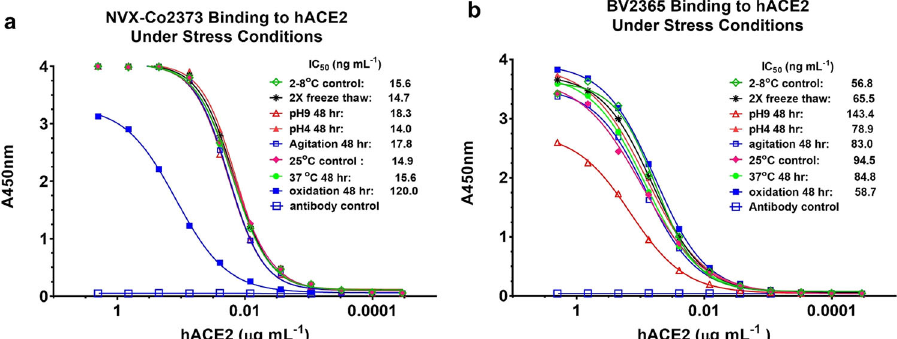
Fig. 3 Stability of SARS-CoV-2 variants under stress conditions. The hACE2 receptor binding ELISA method was used to assess the structural integrity of BV2365 and NVXCoV2373 under stressed conditions. a NVXCoV2373 and b BV2365 were exposed to repeat freeze – thaw cycles, pH extremes, agitation, elevated temperatures, and oxidation for extended periods as indicated. Treated samples were immobilized on 96-well plates, then incubated with serially diluted (2 – 0.0001 μ g mL − 1 ) histidine-tagged hACE2. Bound receptor was detected with HRP-conjugated rabbit anti-histidine IgG. Source data are provided as a Source Data fi